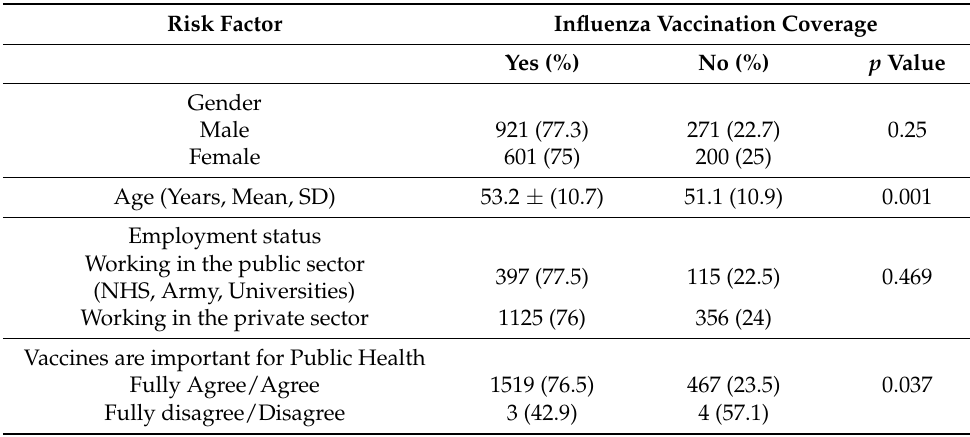
Table 1. Univariable analysis of influenza vaccination coverage (season: